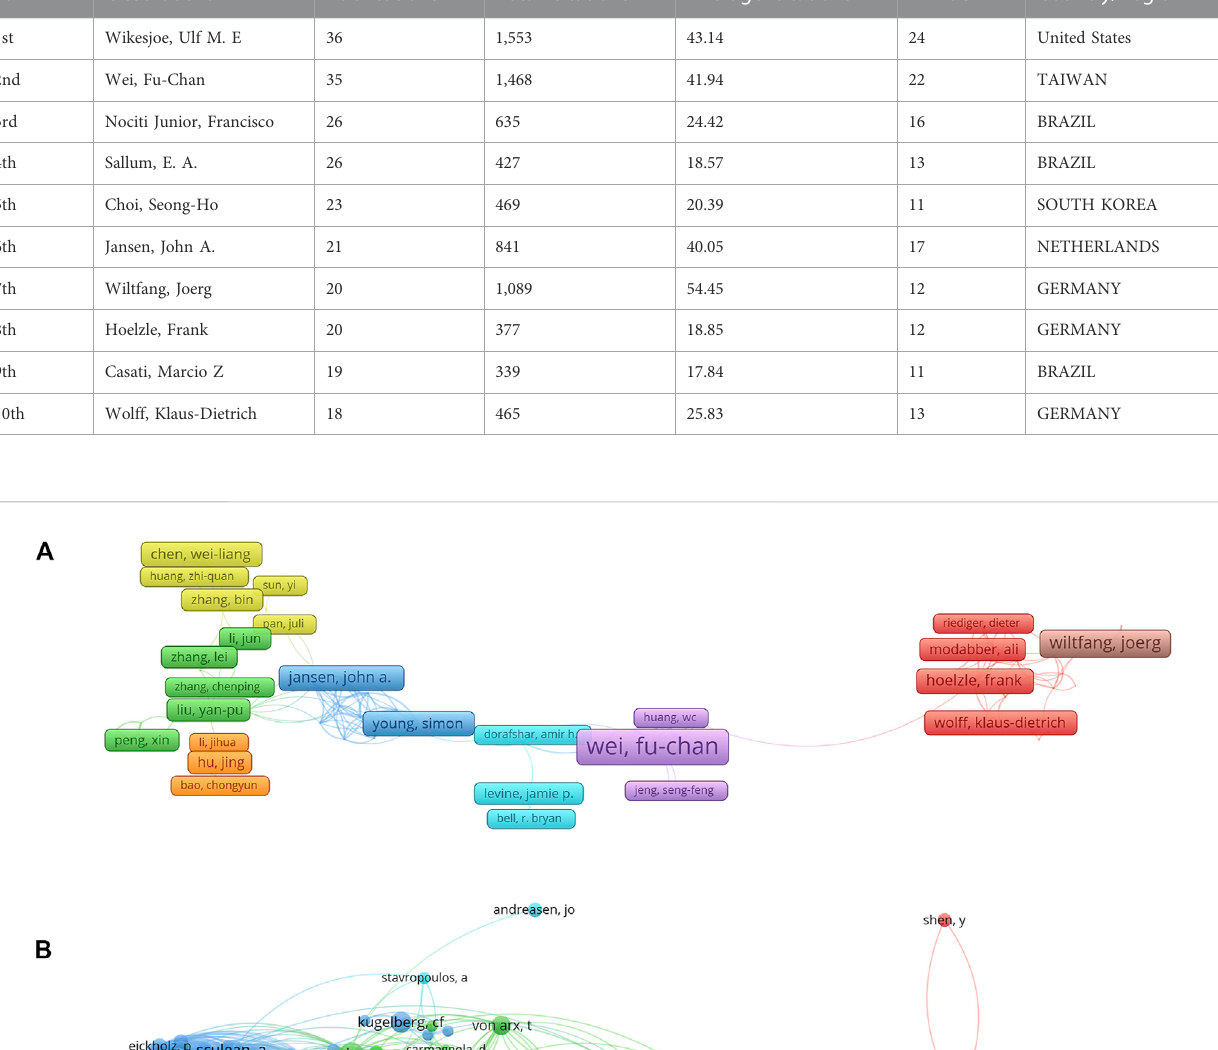
( Figure 7A ) . The frequency of the keywords was constructed to ascertain their density, mandibular defect, mandibular reconstruction, and bone regeneration occupying a core part of the mandibular defect fi eld ( Figure 7B ) . The top 20 keywords with the strongest citation bursts represented the frontiers in the mandibular defect fi eld. The burst strength ranged from 7.31 to 19.84, suggesting that head and neck cancer, accuracy, and root canal preparation were frontiers in the mandibular defect fi eld (Figure 7C).